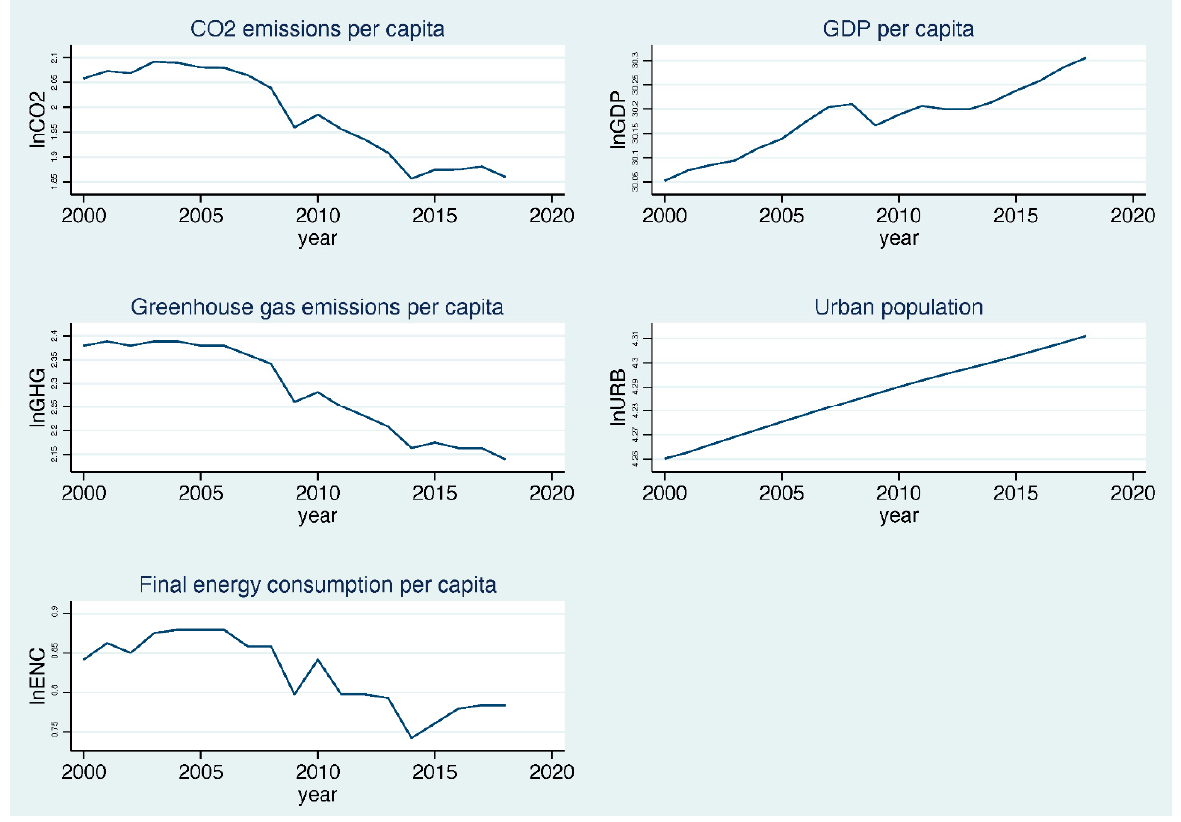
Figure 2. CO (cid:2870) emissions per capita, greenhouse gas emissions per capita, GDP per capita, urban